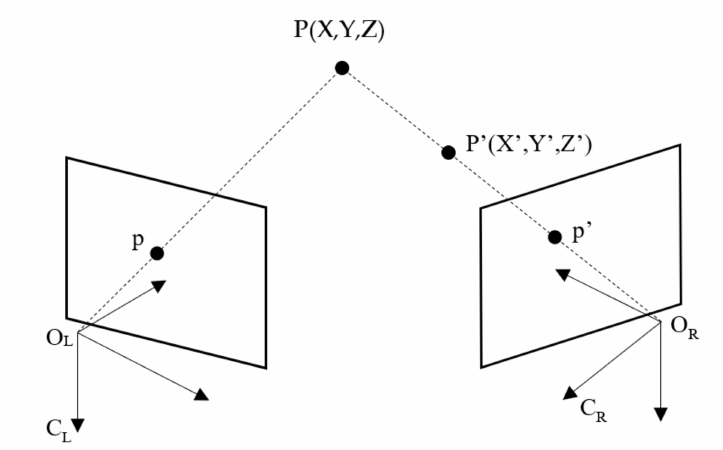
Figure 2. The basic principle of binocular stereo